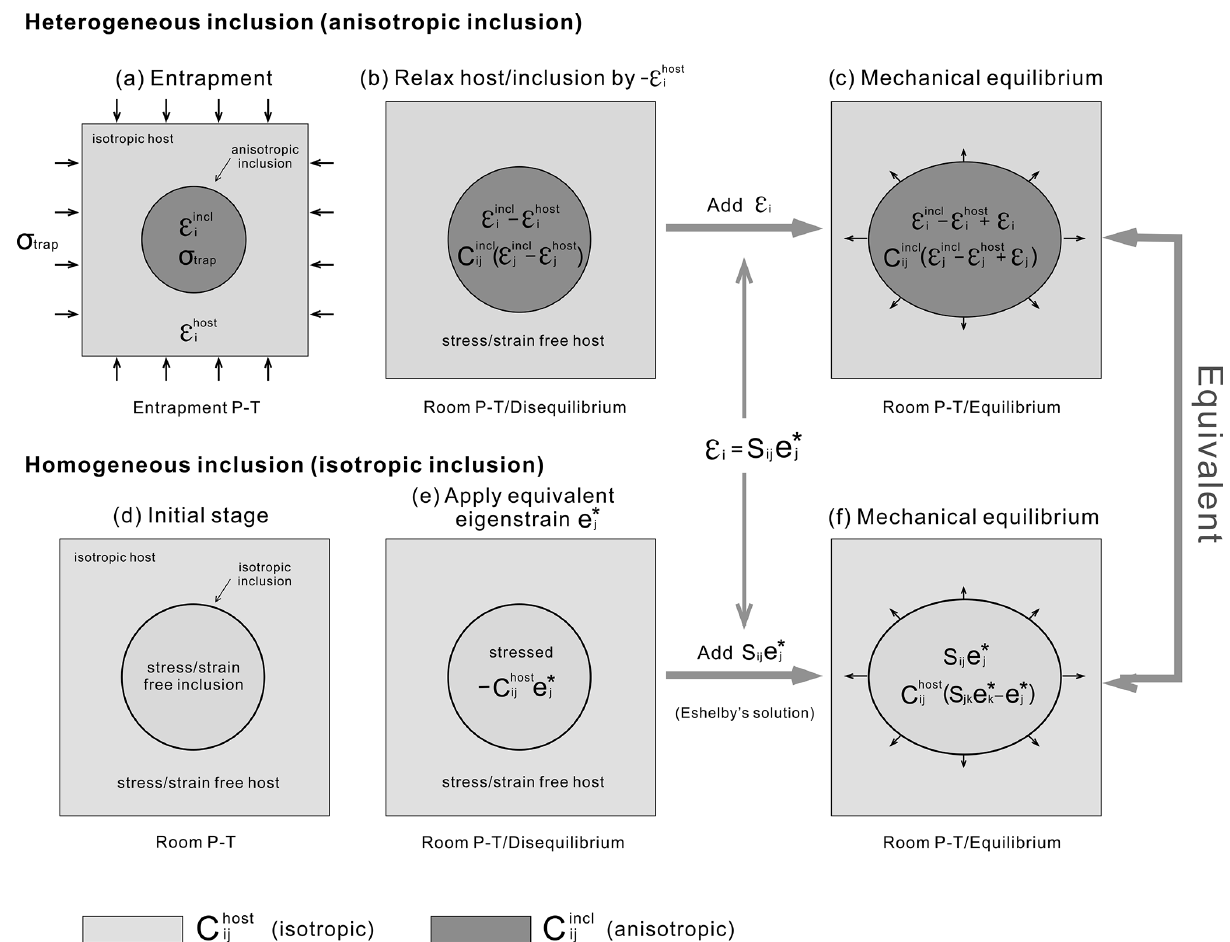
Figure 1. Schematic diagram showing how to obtain the residual stress and strain of anisotropic inclusion in isotropic host. (a) Inclusion– host at entrapment conditions. The stress is homogeneous, σ trap , but strains are different, ε incl and ε host . (b) First, relax the inclusion and i i − ε host − ε host (ε incl ) , and host by − ε host to room P – T conditions. Without elastic interaction, the inclusion has strain ε incl and stress C incl i i i ij j j thus the system is not in mechanical equilibrium. (c) Elastic interaction occurs to reach equilibrium by adding strain ε i to the inclusion (host − ε host + ε j ). (d) Equivalent scenario where the inclusion and host are initially (ε incl also deforms). The residual inclusion stress is C incl ij j j stress-free at room P – T and they both have isotropic elasticity of C host . (e) Equivalent eigenstrains e ∗ are loaded to the inclusion. Without ij i e ∗ elastic interaction, the inclusion has stress − C host . Eshelby’s method is applied to obtain the final strain state in isotropic inclusion, S ij e ∗ , ij j j − e ∗ (S jk e ∗ ) , where S ij is the Eshelby tensor (Eshelby, 1957). The equivalent eigenstrain method states that by properly and stress, C host ij k j − e ∗ (S jk e ∗ ) , equals choosing e ∗ , the relation ε i = S ij e ∗ can be satisfied (Mura, 1987, chap. 4). The stress of isotropic inclusion (f) , C host i j ij k j (cid:16) (cid:17) − ε host + S jk e ∗ ε incl the stress of the anisotropic inclusion (c) , C incl (see Eq. 7). By solving for e ∗ , we obtain the residual stress and strain ij j j k j of anisotropic inclusion in isotropic host in Eq.